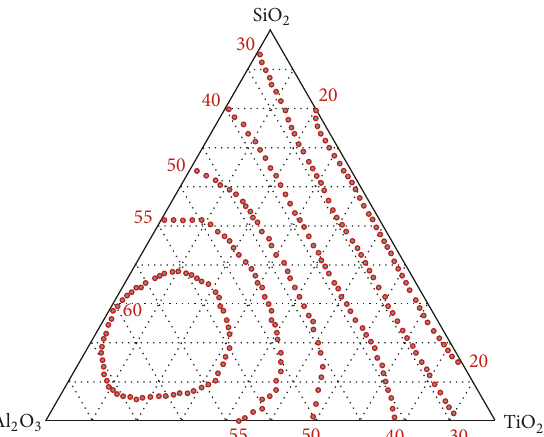
Figure 2: Open porosity isolines (circles) for the system from Table 2, drawn on the basis of calculations conducted based on formula (3). The dotted lines define the specified powder portion in the mixture (100% at the indicated apex of the triangle and 0% at an opposed side).